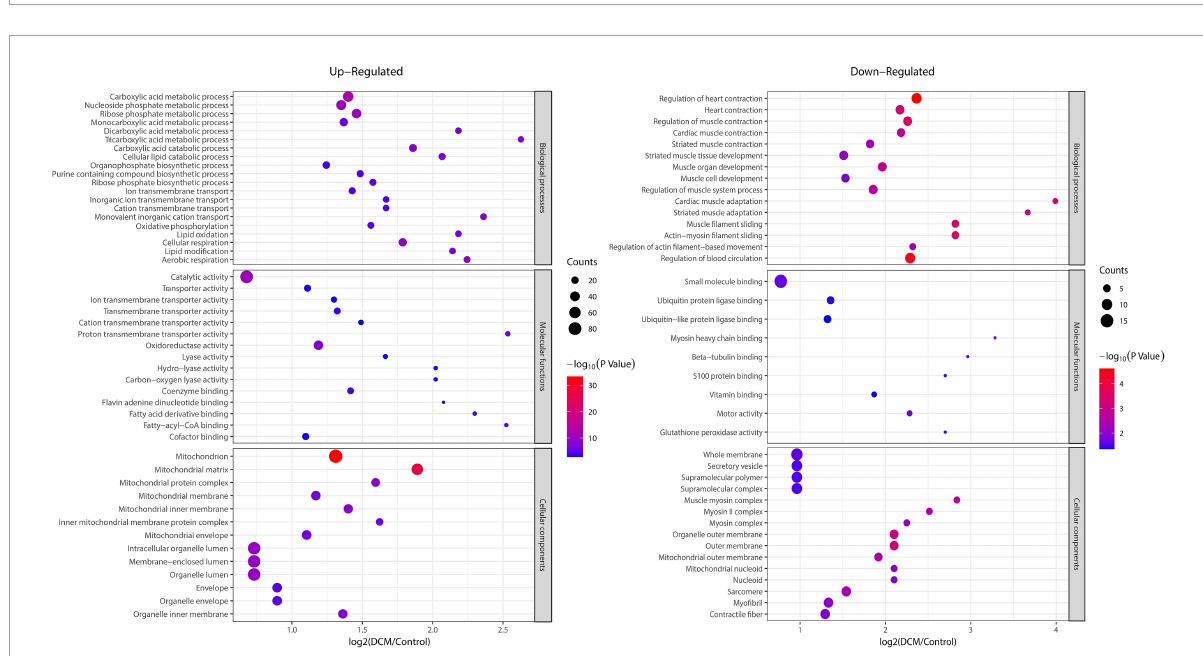
FIGURE5 Enrichment analysis of the lysine β -hydroxybutyrylation (kbhb) proteins based on gene ontology (GO) in heart tissue of diabetic cardiomyopathy (DCM) rats. (left) Upregulated. (right) Downregulated.